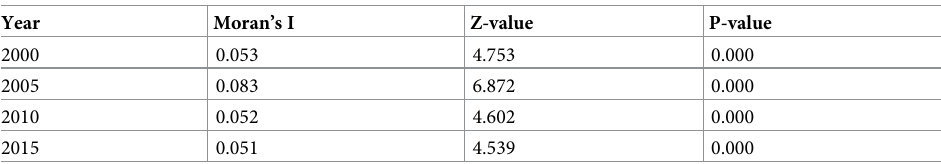
Table 1. Global Moran’s I